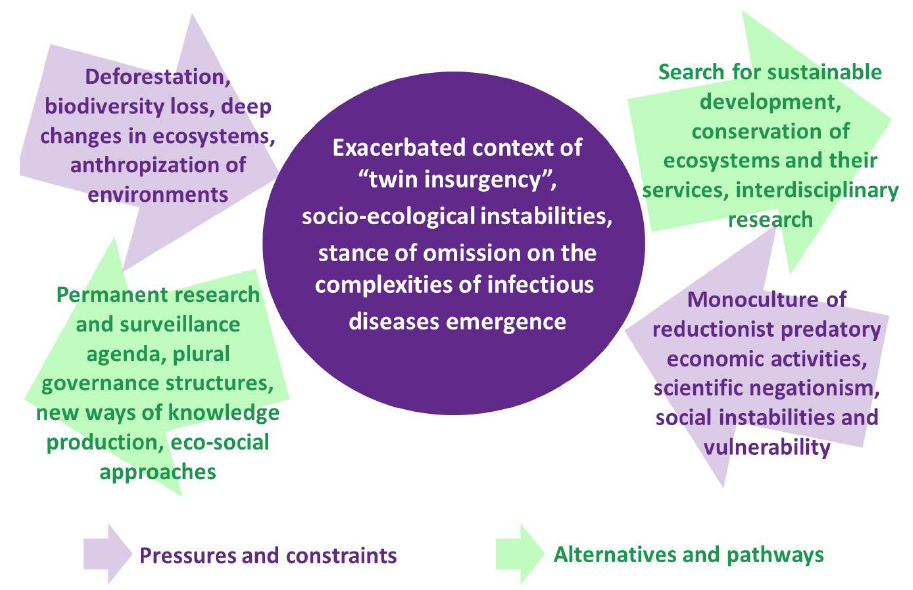
Figure 1 – Model of pressures and alternatives to the context of twin insurgency of emergent infectious